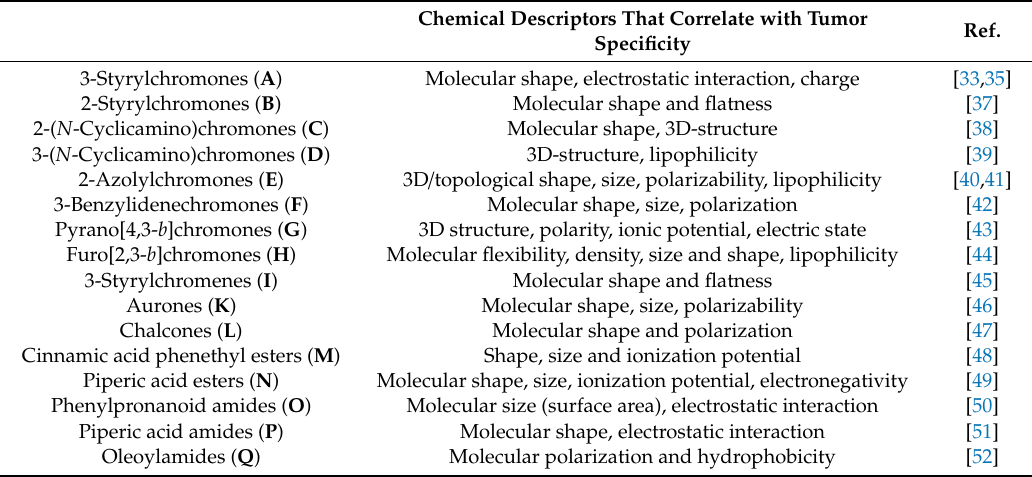
Table 4. Molecular shape is the key determinant of tumor specificity.